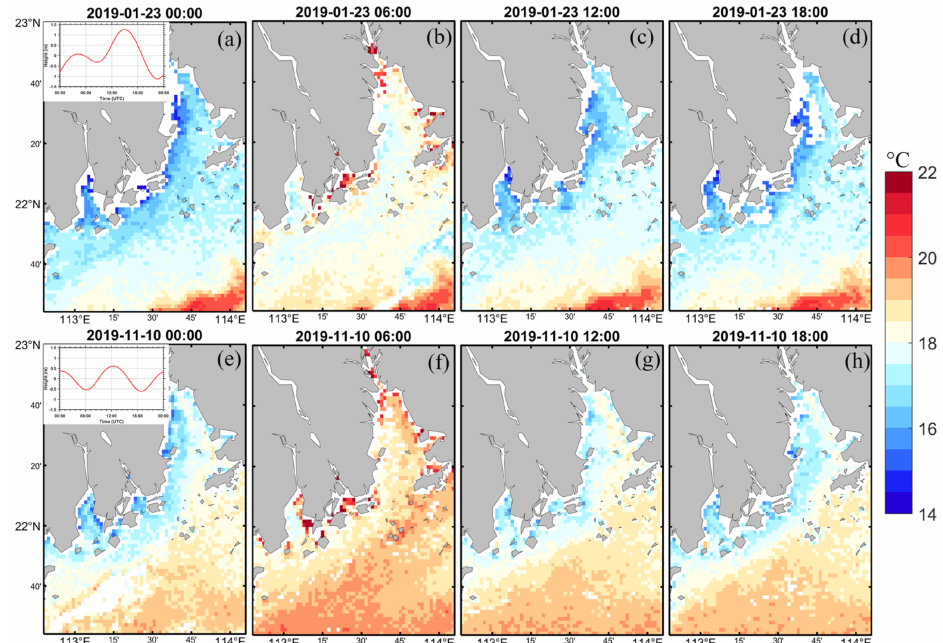
Figure 2. Ten-minutely sea surface temperature (SST) on 23 January ( a – d ) and 10 November 2019 ( e – f ). Corresponding tidal heights are shown in upper-left corners of ( a , e ). The subtitles in subplots ( a – h ) indicate the corresponding observation time (unit: UTC).